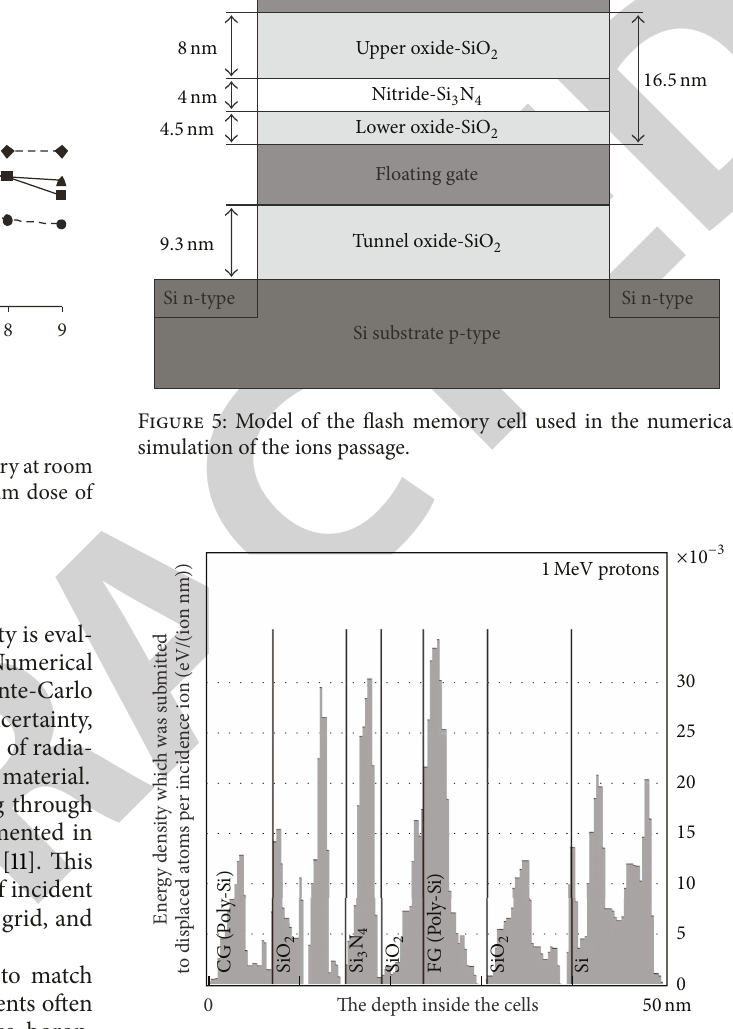
Figure 6: Energy density of incident protons per unit of depth which is submitted to atoms displaced in the layers of the flash cell (expressed per incident proton) for 1MeV